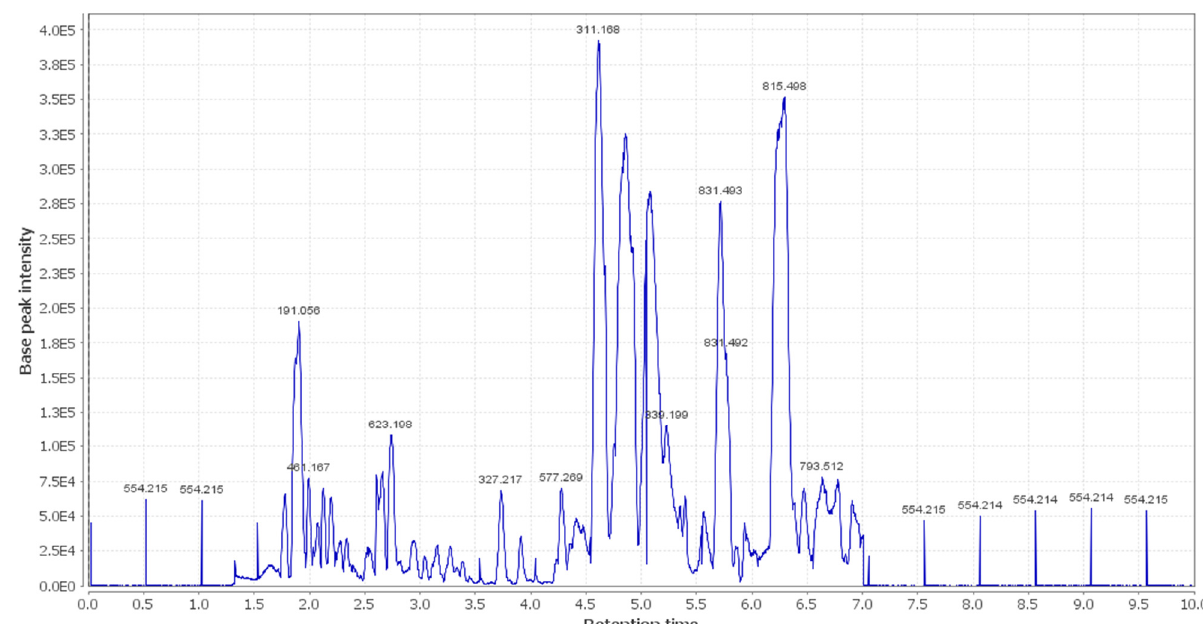
Figure 2. LC-HRESIMS chromatogram of the dereplicated metabolites of OEA (positive mode).